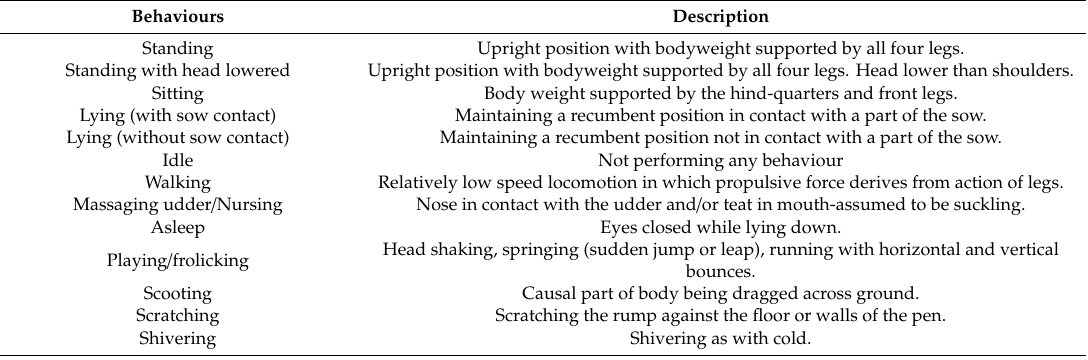
Table 1. Description of piglet behaviours observed (modified from Hay et al. and Hurnik et al. [13,20]. Behaviours